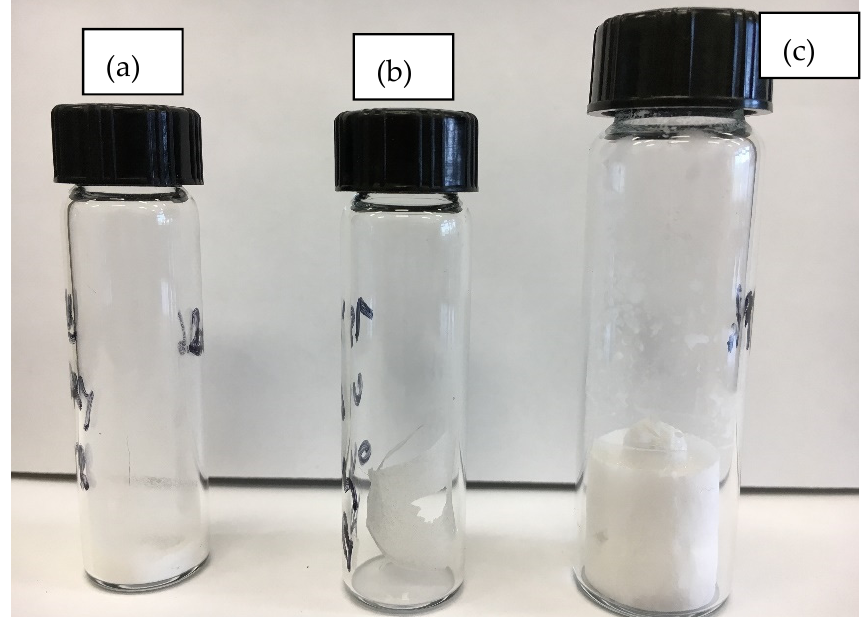
Figure 6. Different macro-morphologies of the potato starch from “Gabrielle” cultivar after treatment using ultrasonication under dry conditions ( a ); ultrasonication under wet conditions followed by drying in a vacuum oven at 40 °C ( b ); ultrasonication under wet conditions followed by drying by lyophilization ( c ).